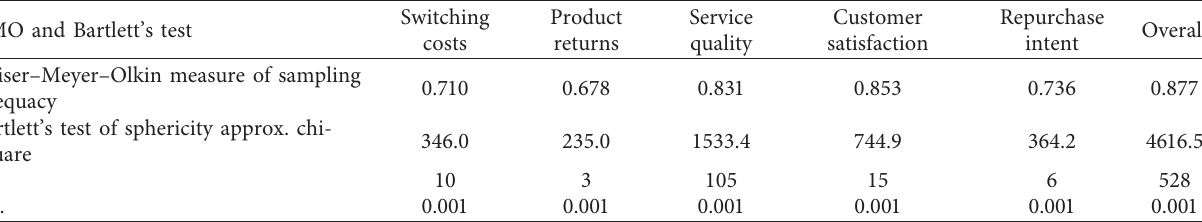
Table 5: KMO and Bartlett’s